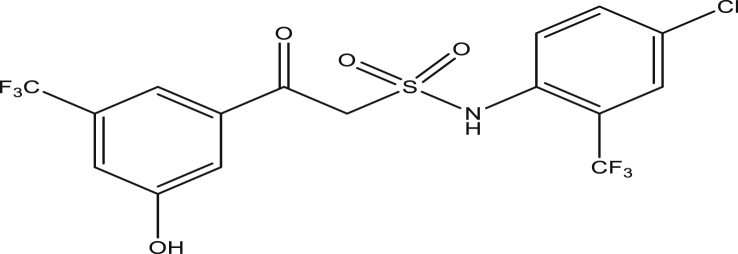
Compound 9j [N-(4-chloro-2-(trifluoromethyl)phenyl)-2-(3-hydroxy-5-(trifluoromethyl)phenyl)-2-oxoethanesulfonamide (pEC500.071154)].